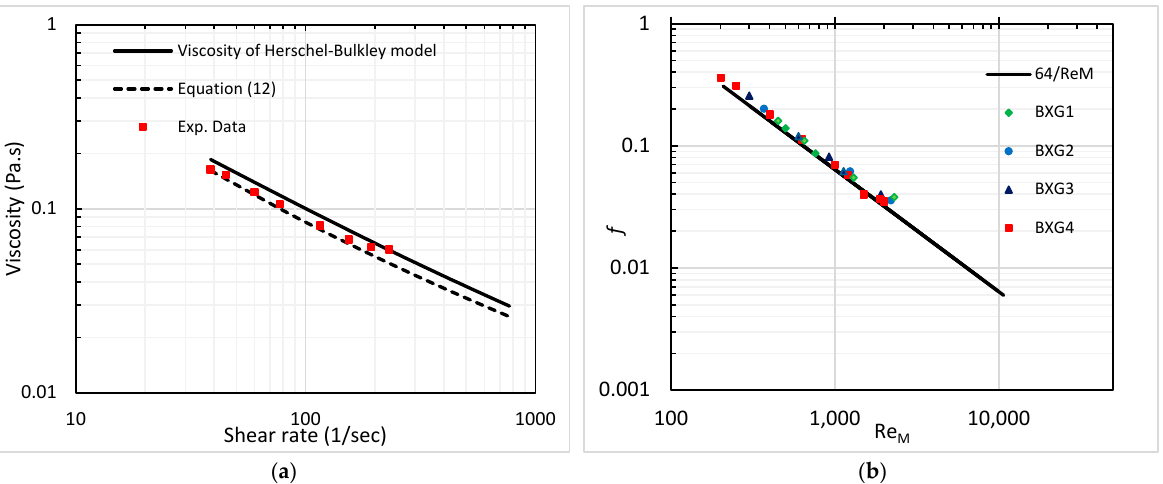
Figure 7. Comparison of the predicted and experimental data for Herschel–Bulkley fl uids in pipe diameter 76.2 mm. ( a ) Estimated and experimental viscosity vs. Herschel–Bulkley viscosity for polymer solutions BXG4. ( b ) Laminar data of Herschel–Bulkley fl uids (BXG1, BXG2, BXG3, and BXG4).